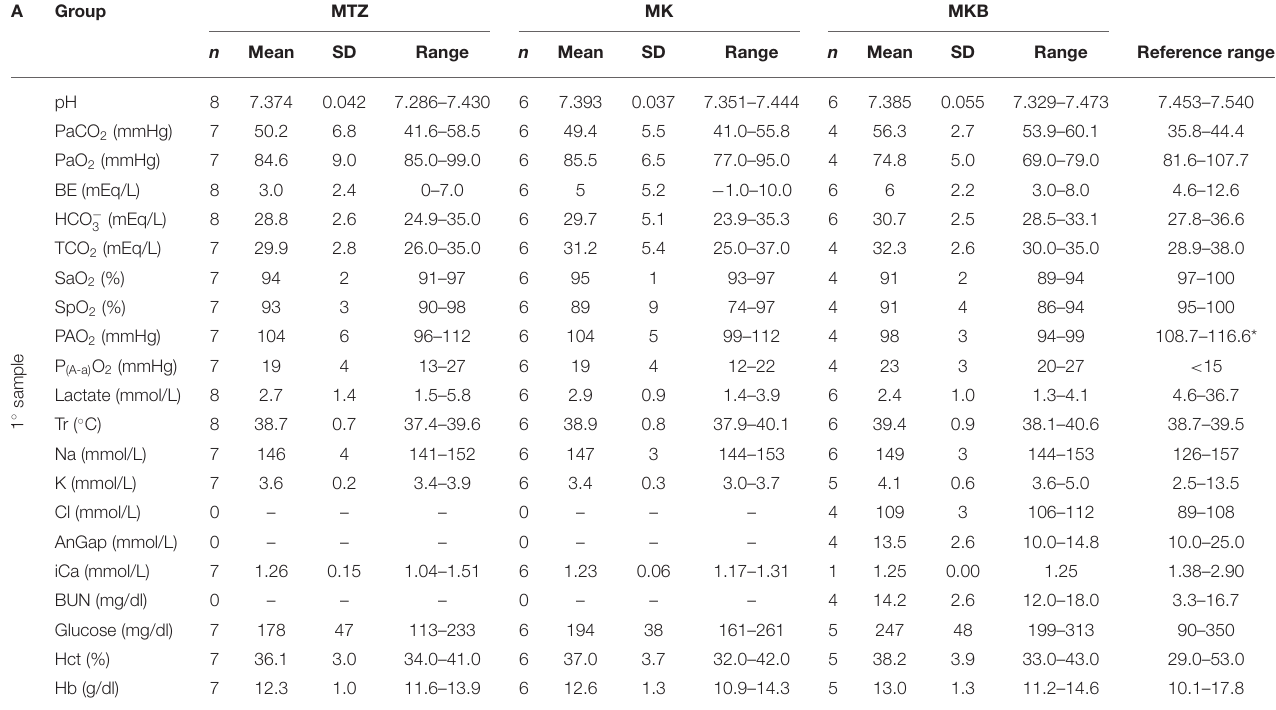
TABLE 4A | Blood gas, hematological and serum biochemistry variables before oxygen supplementation of cage-trapped wild boars anesthetized using medetomidine-tiletamine-zolazepam (MTZ; n = 8) or medetomidine-ketamine (MK; n = 6) or medetomidine-ketamine-butorphanol (MKB; n =